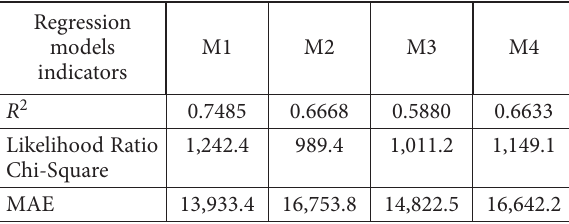
Table 5. Regression model choice Regression